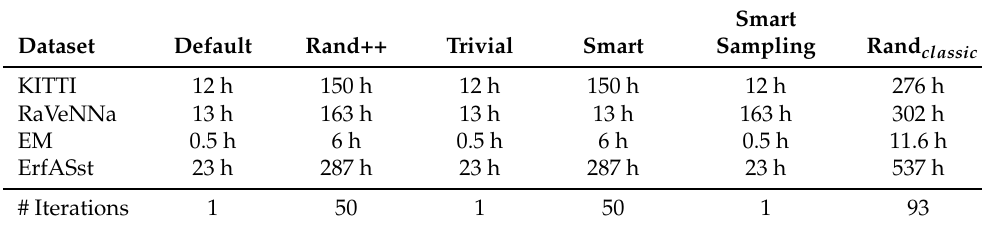
Table 4. Approximate estimate of computing costs (in hours) for each dataset and augmentation approach. The costs are the time required until the maximum number of epochs is reached. Due to computational resource constraints, we run Smart, Rand++, Rand classic with four GPUs in parallel. Rand classic is RandAugment that uses GridSearch for optimization.